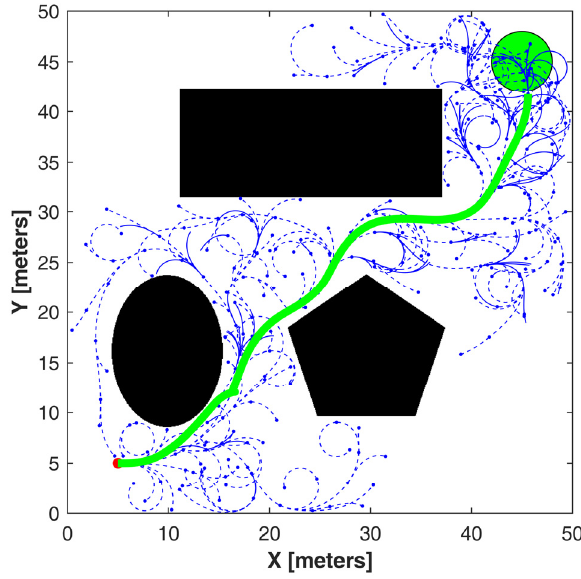
Figure 6. An example of spRRT ‐ Informed trace.